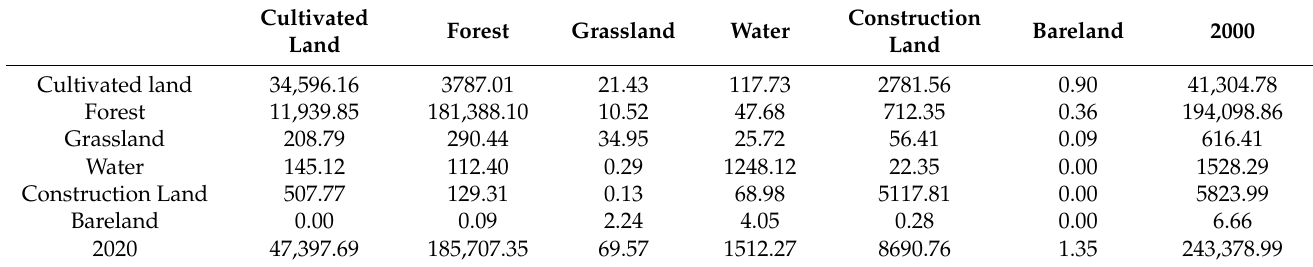
Figure 3. Status of land use in Ruijin City from 2000 to 2020. Table 4. Ruijin City land use transfer matrix from 2000 to 2020 (Unit: hm 2